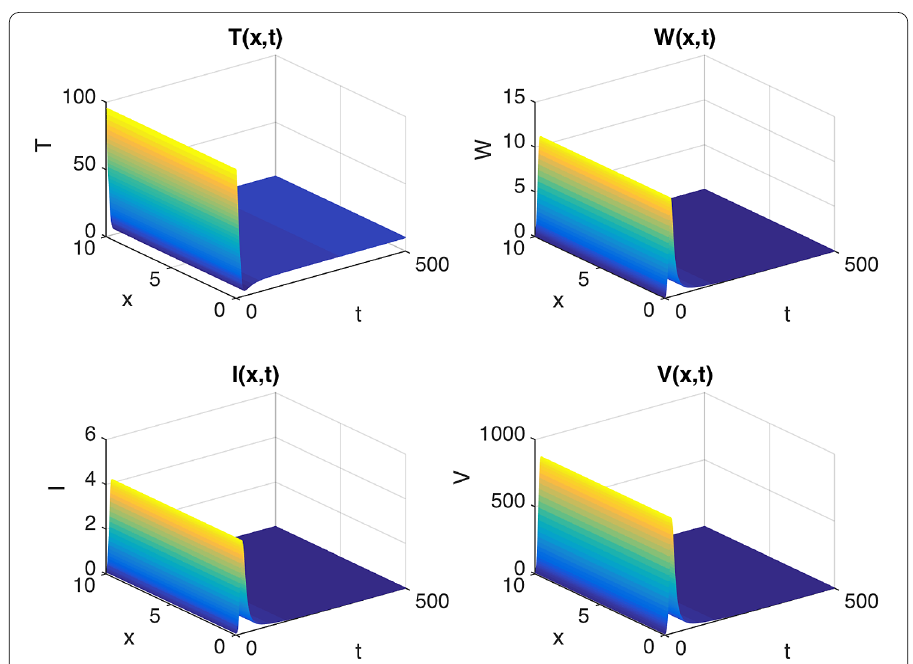
Figure 1 R 0 = 0.1065 < 1. The infection-free equilibrium E 0 is globally asymptotically stable